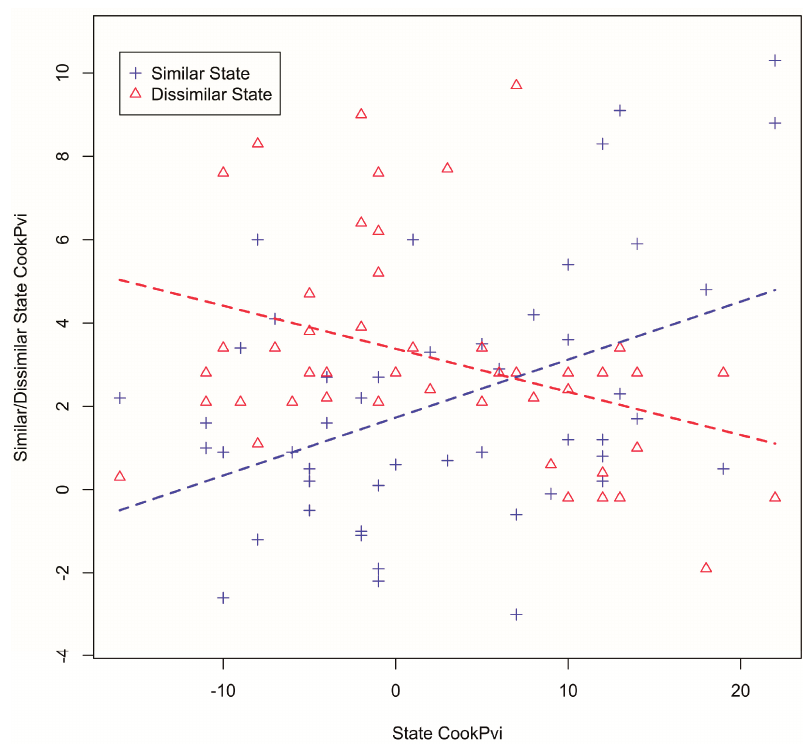
Figure 5. Scatterplot with fixed regression lines comparing a state’s Cook PVI with the average Cook PVIs of its 10 most similar states (blue) and 10 most dissimilar states